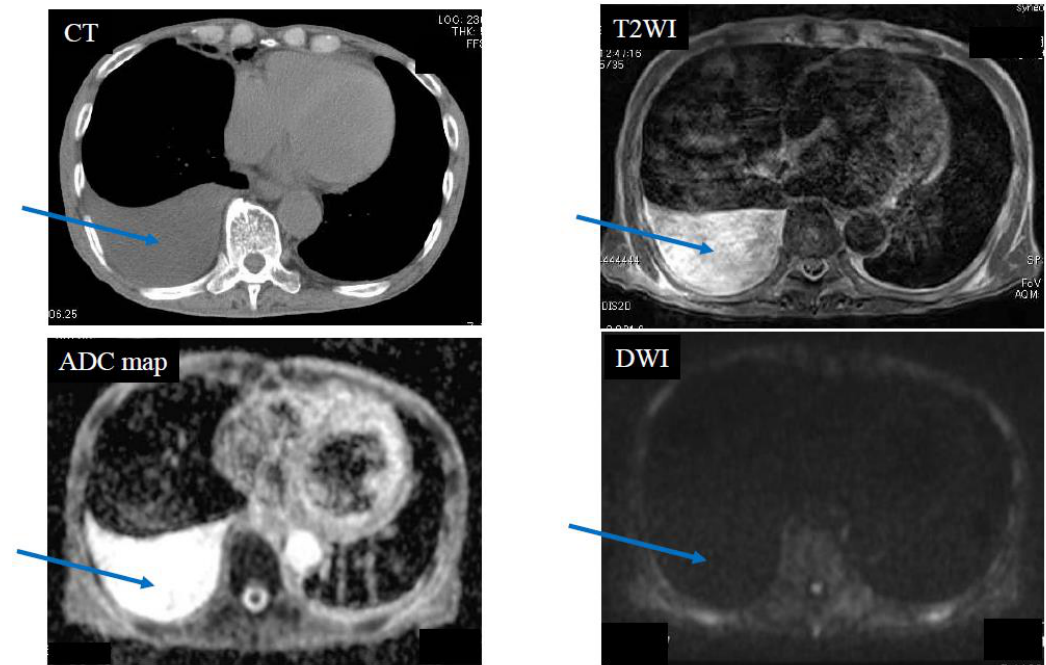
Figure 4. Case 4 — Pleural effusion due to exudative pleurisy in a 79-year-old male, who suffered from Figure 4. Case 4—Pleural e ff usion due to exudative pleurisy in a 79-year-old male, who su ff ered from right pneumonia. The blue arrows indicate pleural fluid. Pleural effusion was not seen in diffusion right pneumonia. The blue arrows indicate pleural fluid. Pleural e ff usion was not seen in di ff usion weighted magnetic resonance imaging (DWI). The apparent diffusion coefficient (ADC) of pleural weighted magnetic resonance imaging (DWI). The apparent di ff usion coe ffi cient (ADC) of pleural fluid fluid was 4.02 × 10 -3 mm 2 /s (negative). was 4.02 × 10 − 3 mm 2 / s